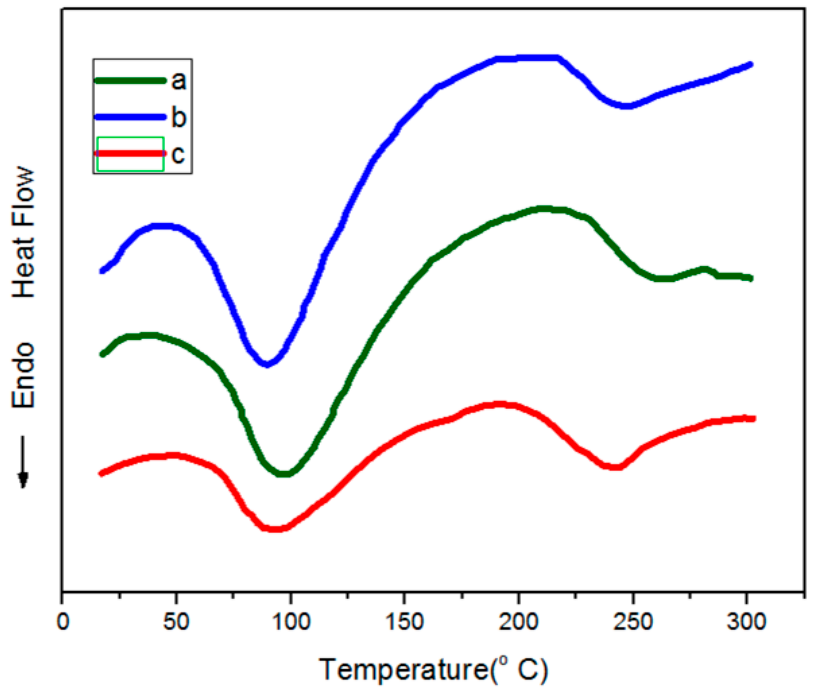
Figure 8. DSC thermograms of the core-shell microgel ( a ), the nanocomposite microgel ( b ) and the copolymeric hydrogel ( c ).